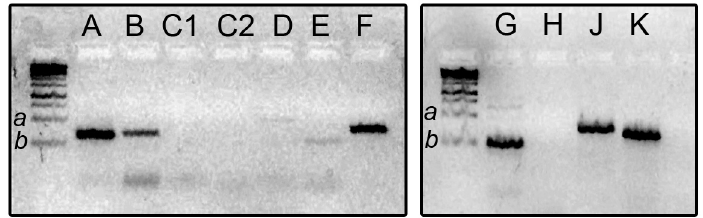
Figure 3. PCR detection of mRNAs for TMEM16 family members in colonic tissue. Colonic epithelium was stripped of its muscle layers and mRNA was isolated and reverse transcribed (59). PCR was performed using specific primers for members of the TMEM16 family using a single cDNA sample. Lanes contained a 1-kB ladder ( a and b correspond to the 500- and 250-bp marker, respectively) and then TMEM16A (324 bp), TMEM16B (330 bp), TMEM16C1 (341 bp), TMEM16C2 (320 bp), TMEM16D (493 bp), TMEM16E (226 bp), TMEM16F (380 bp), 1-kB ladder, TMEM16G (248 bp), TMEM16H (296 bp), TMEM16J (374 bp), and TMEM16K (329 bp). The PCR conditions included 35 cycles with annealing temperature of 55°C. A representative experiment of three different ones performed with independent cDNA samples is shown. Control experiments were carried out using whole brain, and olfactory epithelium obtained from mice and rats confirmed the ability of all primer sets to amplify the expected products (González C and Bacigalupo J, unpublished